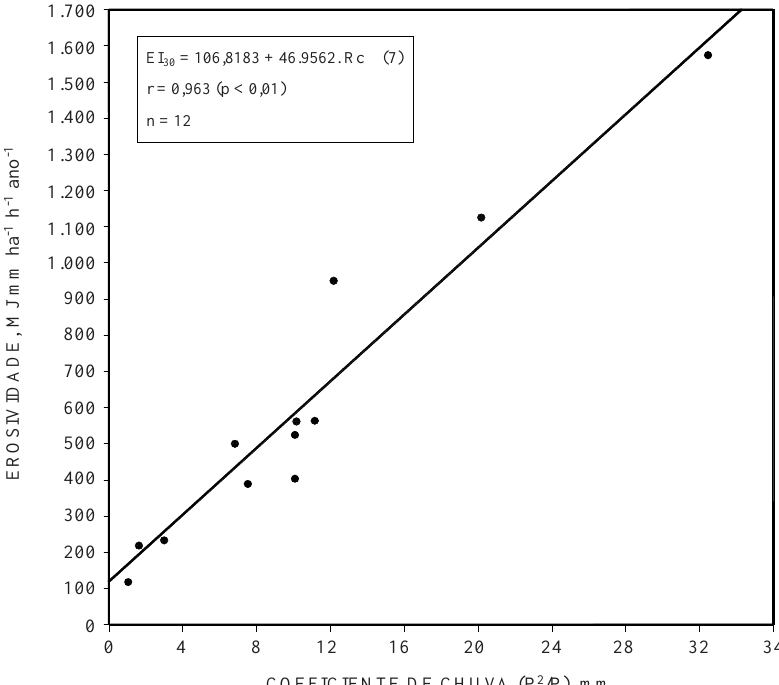
Figura 3. Curva de regressão entre o parâmetro de erosividade EI chuva de Teodoro Sampaio (SP) no período de 1976 a 1994.